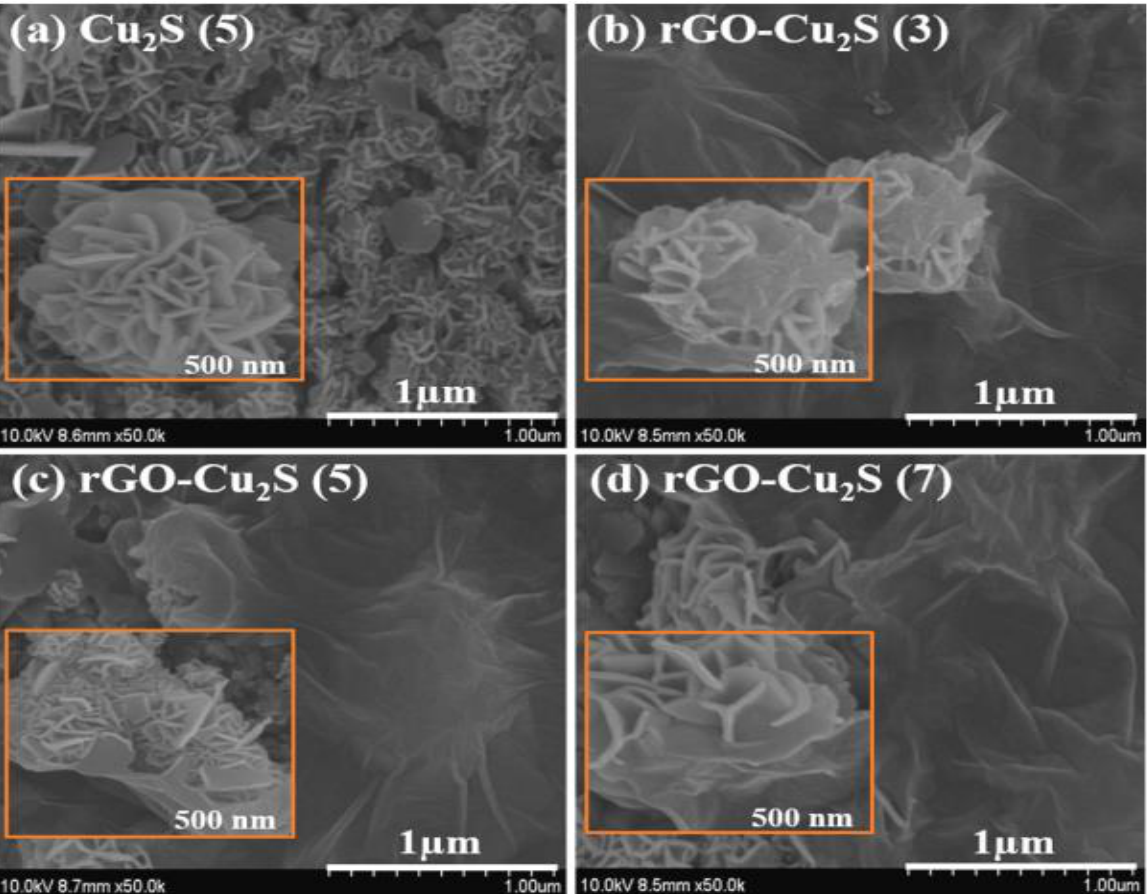
Figure 2. SEM images of ( a ) Cu 2 S and ( b – d ) rGO-Cu 2 S. The images have been reproduced with permission [86].